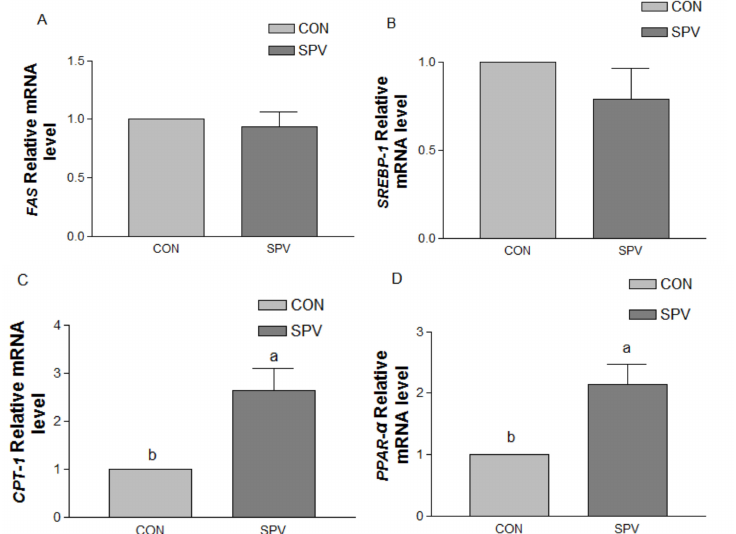
Figure 3. E ff ect of sweet potato vine treatment on FAS ( A ), SREBP-1 ( B ), CPT-1 ( C ), and PPAR- α ( D ) genes’ mRNA expression in liver of Meishan gilt. Values are mean ± SEM (n = 8). CON, gilts fed the basal diet; SPV, gilts fed basal diet with sweet potato vine; FAS , fatty acid synthetase; SREBP-1 , sterol regulatory element binding proteins; CPT-1 , carnitine palmityl transferase; PPAR- α , Peroxisome proliferator activated receptor- α . a, b Means not sharing identical superscripts in the same figure are significantly di ff erent ( p <